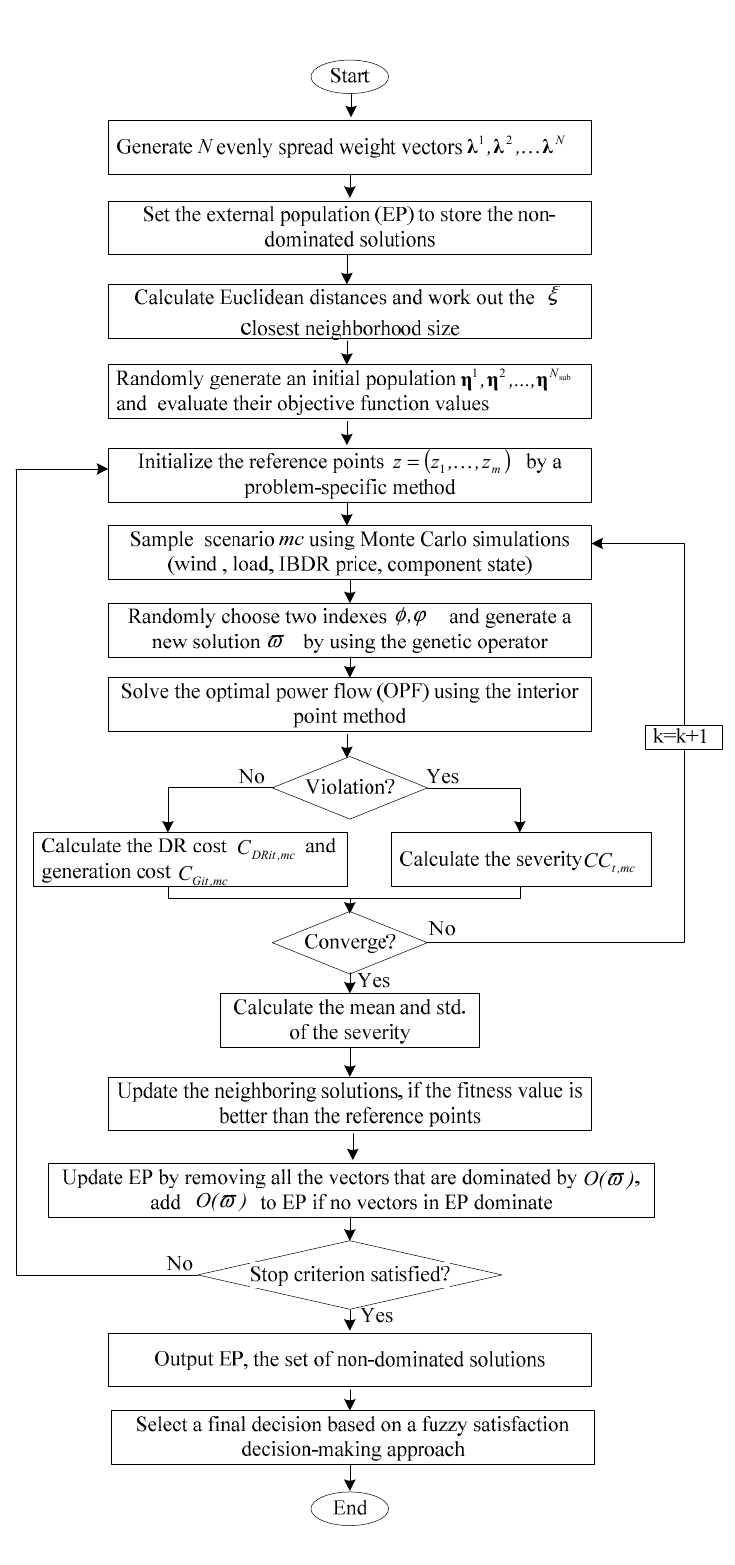
Figure 2. Flow chart of the applied solution algorithm.